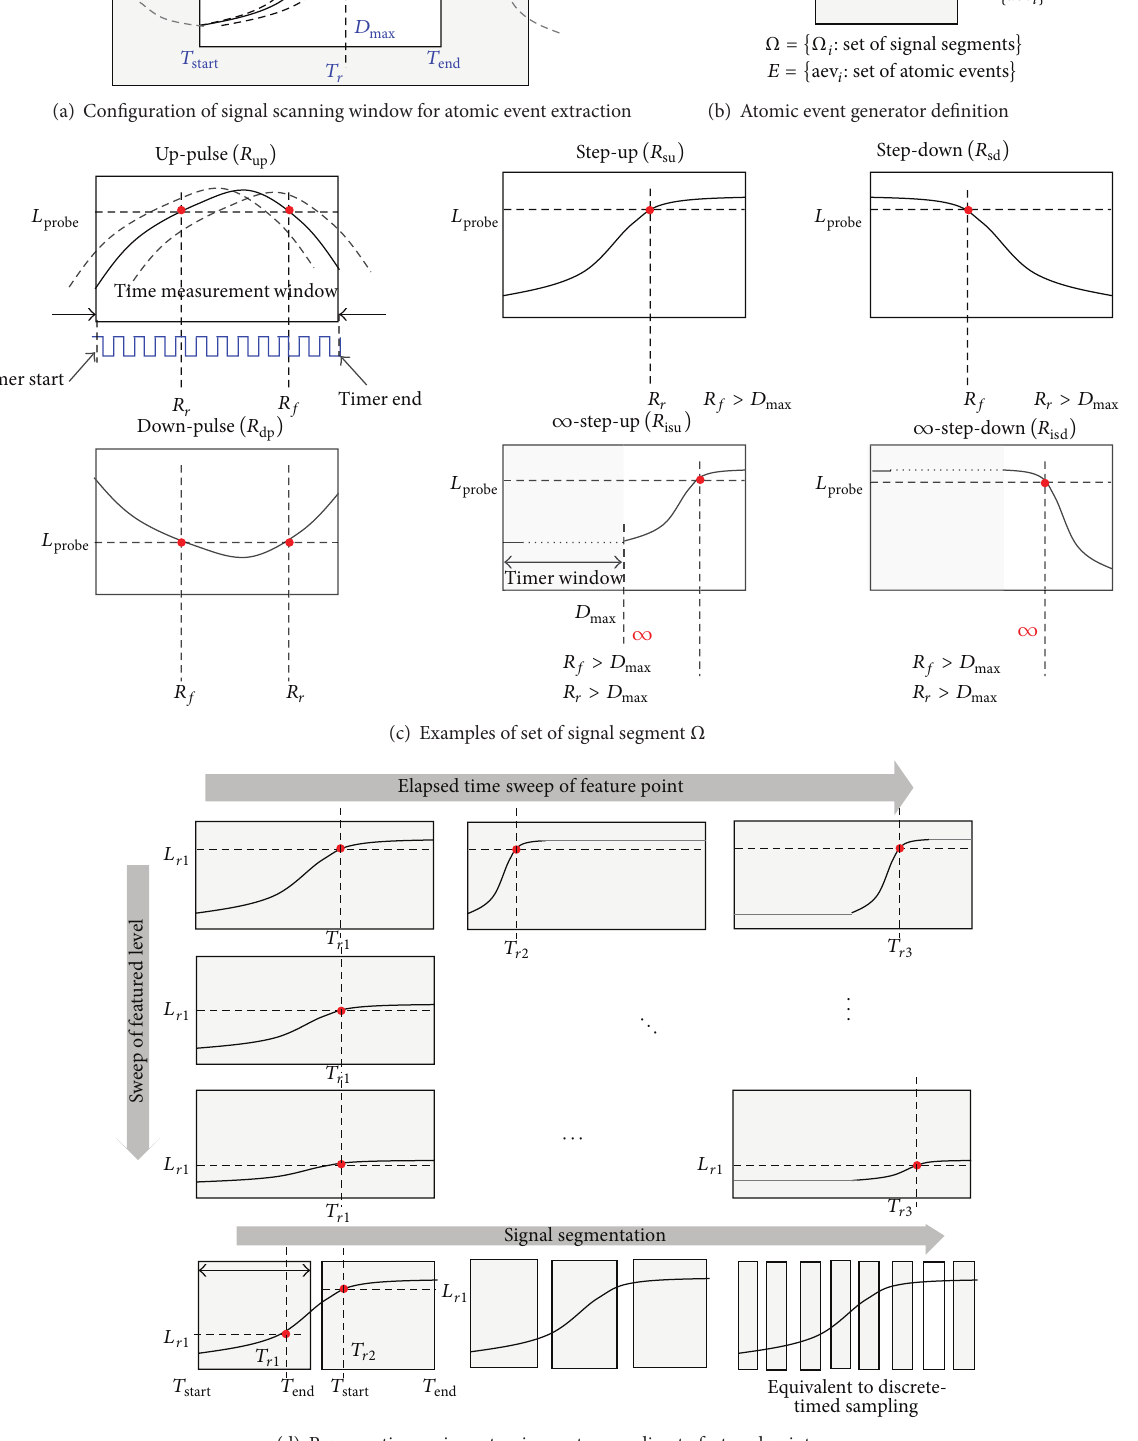
Figure 6: Configuration of signal feature scan window and atomic event